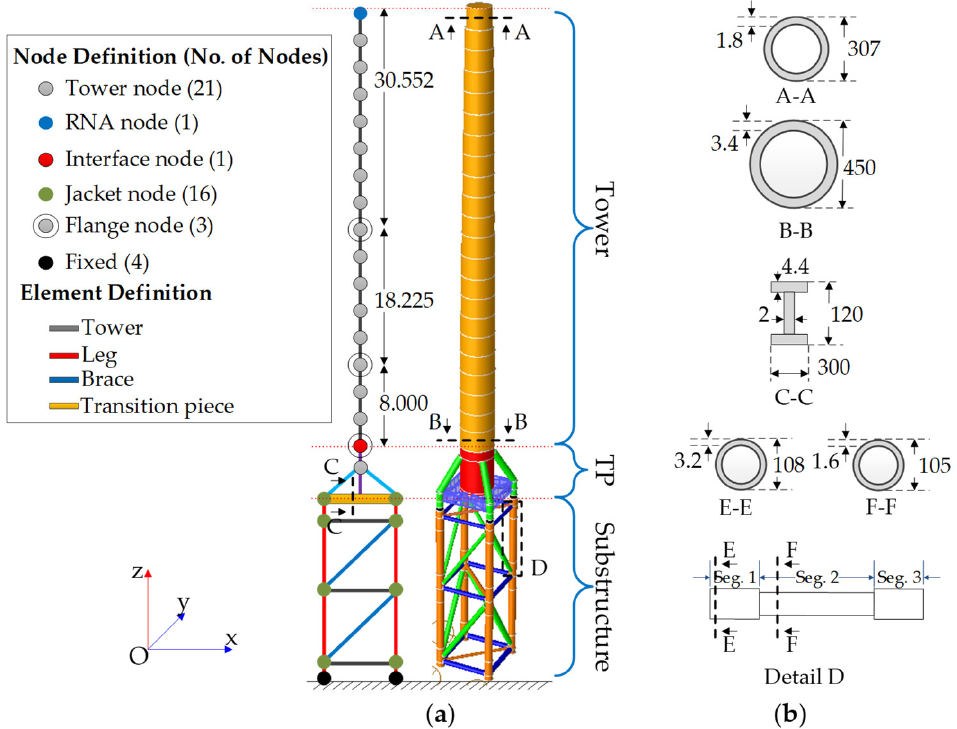
Figure 2. Modeling of the support structure: ( a ) Analysis model; ( b ) Cross-section (cm).